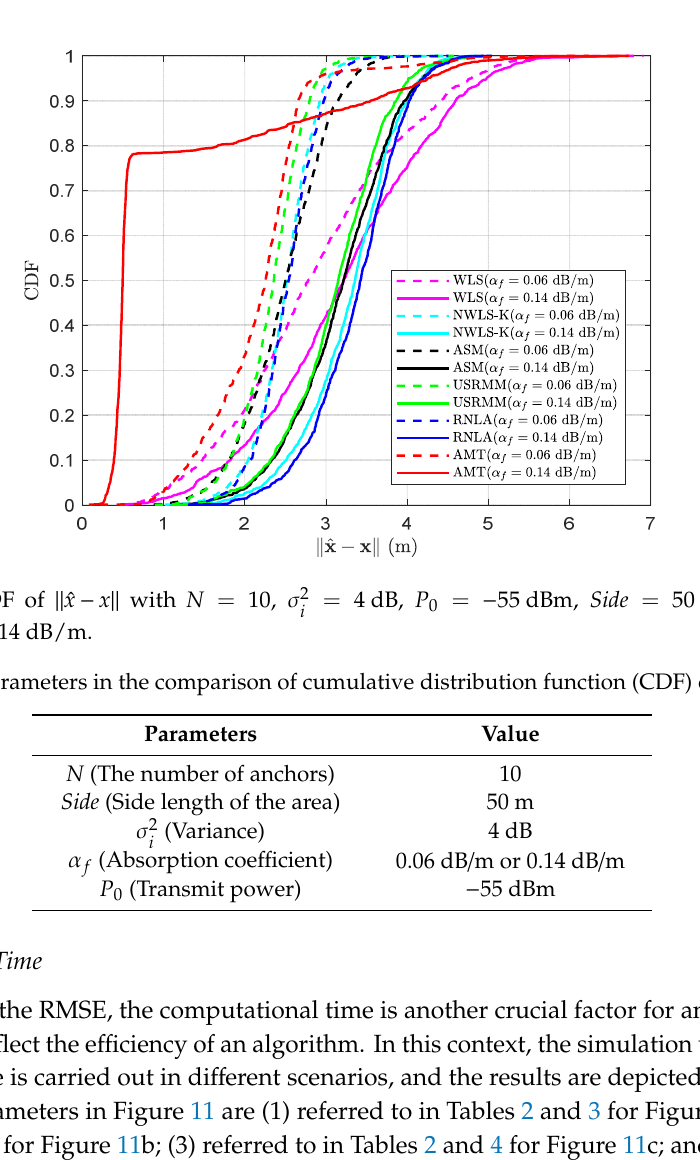
15 of 18 Figure 9. RMSE versus variable side length with